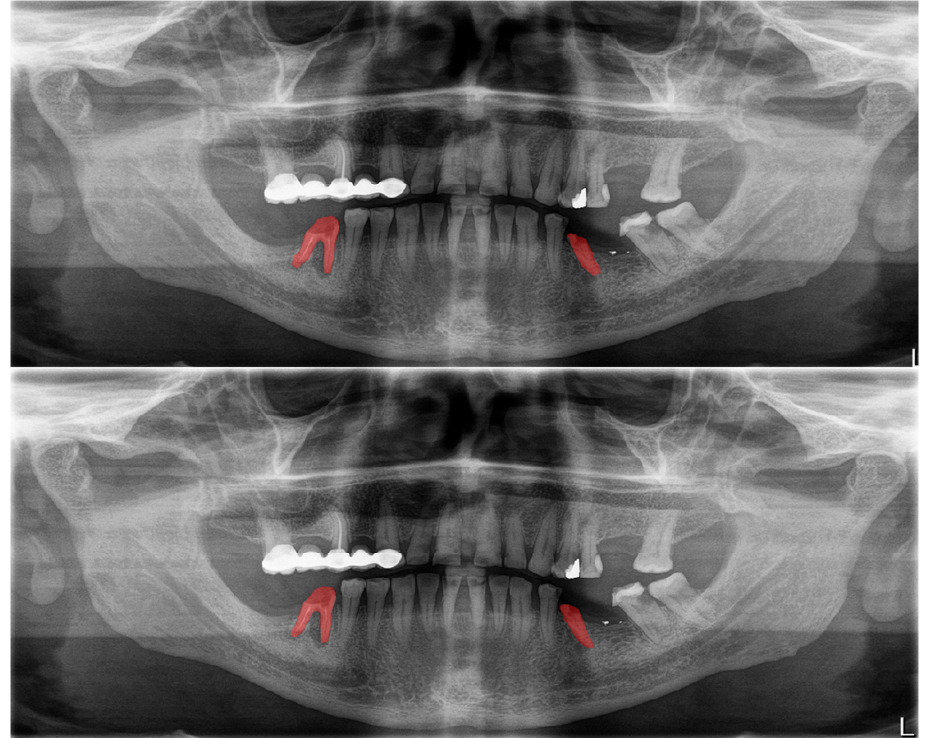
Figure 7. Automatic segmentation of residual roots. Manual segmentation ( upper image ) and automatic segmentation ( lower image ) can be seen above. Most of the erroneous segmentations occurred due to the limitations of OPG devices, and some of the examples are as follows: In Figure 8, a more successful automatic segmentation is observed at the maxillary right third molar than the maxillary left third molar, and a missing segmented area in the form of a notch is observed. As most of the upper third molars were superimposed on the floor of the maxillary sinus and zygomatic process of the maxilla, erroneous segmenta- tions were inevitable. In Figure 9, an erroneous automatic segmentation at the mandibular left second molar due to the superimposition between the mandibular left first and man- dibular left second premolars can be seen.